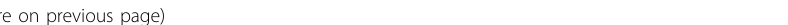
Fig. 6 TRPM8 immunoscoring predicts X-rays + WS-12 ef fi cacy. a TRPM8 immunostaining of BM-18 PDX. Scale bars, 100 μ m. b Western blotting analysis shows comparable expression levels of TRPM8 in BM-18 and RWPE-1 M8 cells. c Immuno fl uorescence images showing co-staining of Ki-67 (green, upper panel) or Cleaved Caspase-3 (green, lower panel) with CK8 (red) and DAPI (blue). d Percentage of Ki-67 positive cells on a total of 30,000 cells in at least fi ve different areas of the sample. Scale bars, 50 μ m. e Western blotting analysis in BM-18 PDX tissues slices upon WS-12 (1 μ M, 48 h), X- rays (10 Gy), or X-ray + WS-12 treatments showing molecular hallmarks of apoptotic cell death (Caspase-3 and PARP cleavage). Error bars, mean ± SD. Data were analyzed using a two-tailed Student ’ s t -test. * P ≤ 0.05; ** P ≤ 0.01; *** P ≤ 0.001. f Representative fl ow cytometry analysis of apoptotic cell death by Annexin-V/Sytox-Green labeling in LNCaP FGC M8 cells treated with WS-12 (1 μ M), docetaxel (5 nM), enzalutamide (1 μ M), WS-12 + docetaxel,